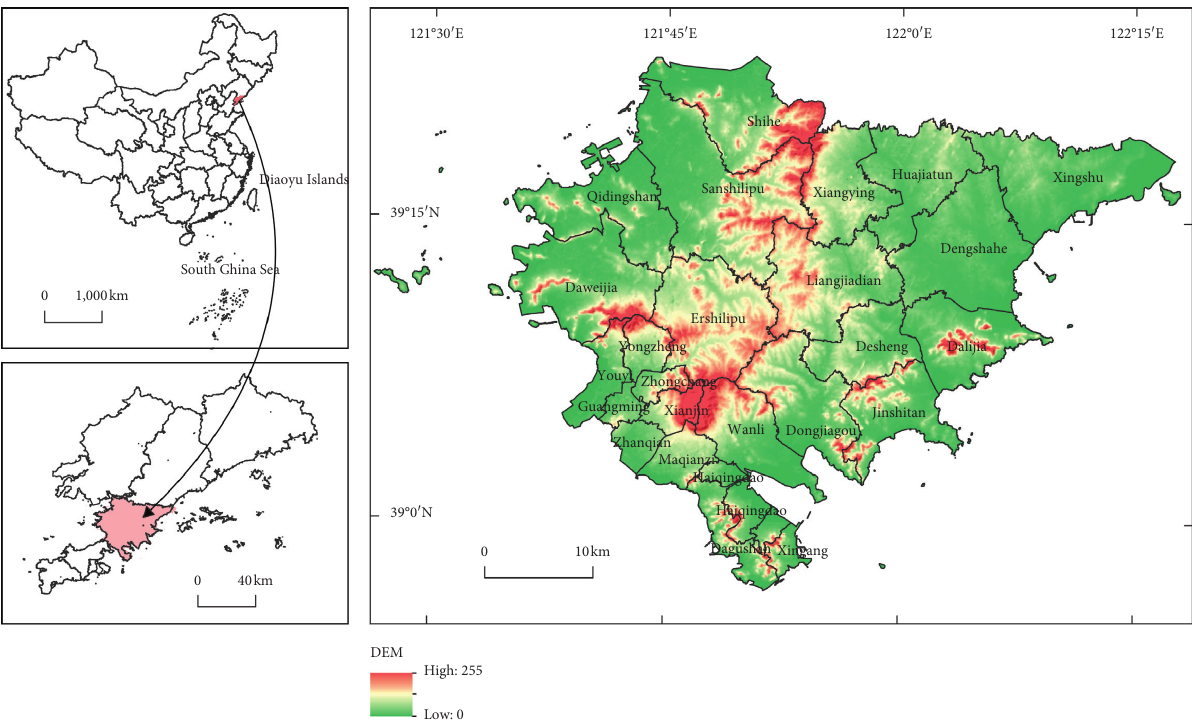
Figure 1: Location of the study area.